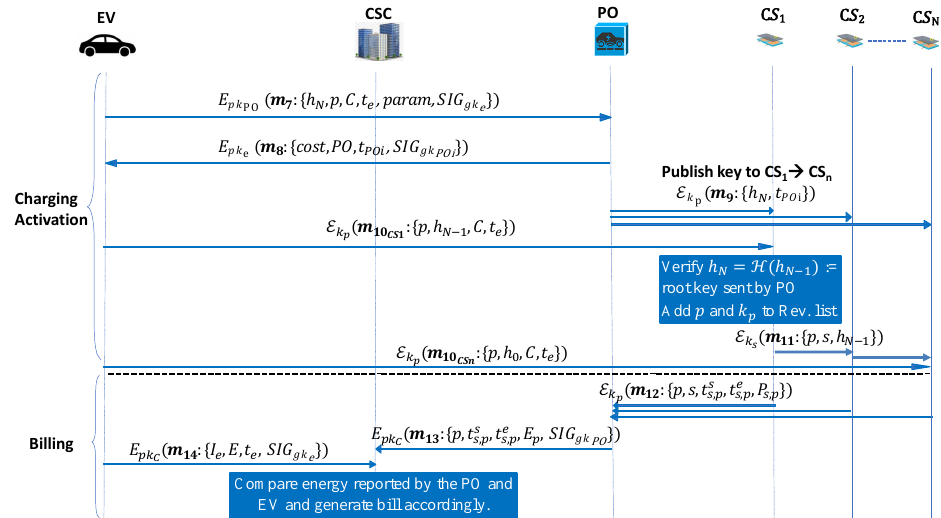
Figure 5. Message sequence of charging activation and billing